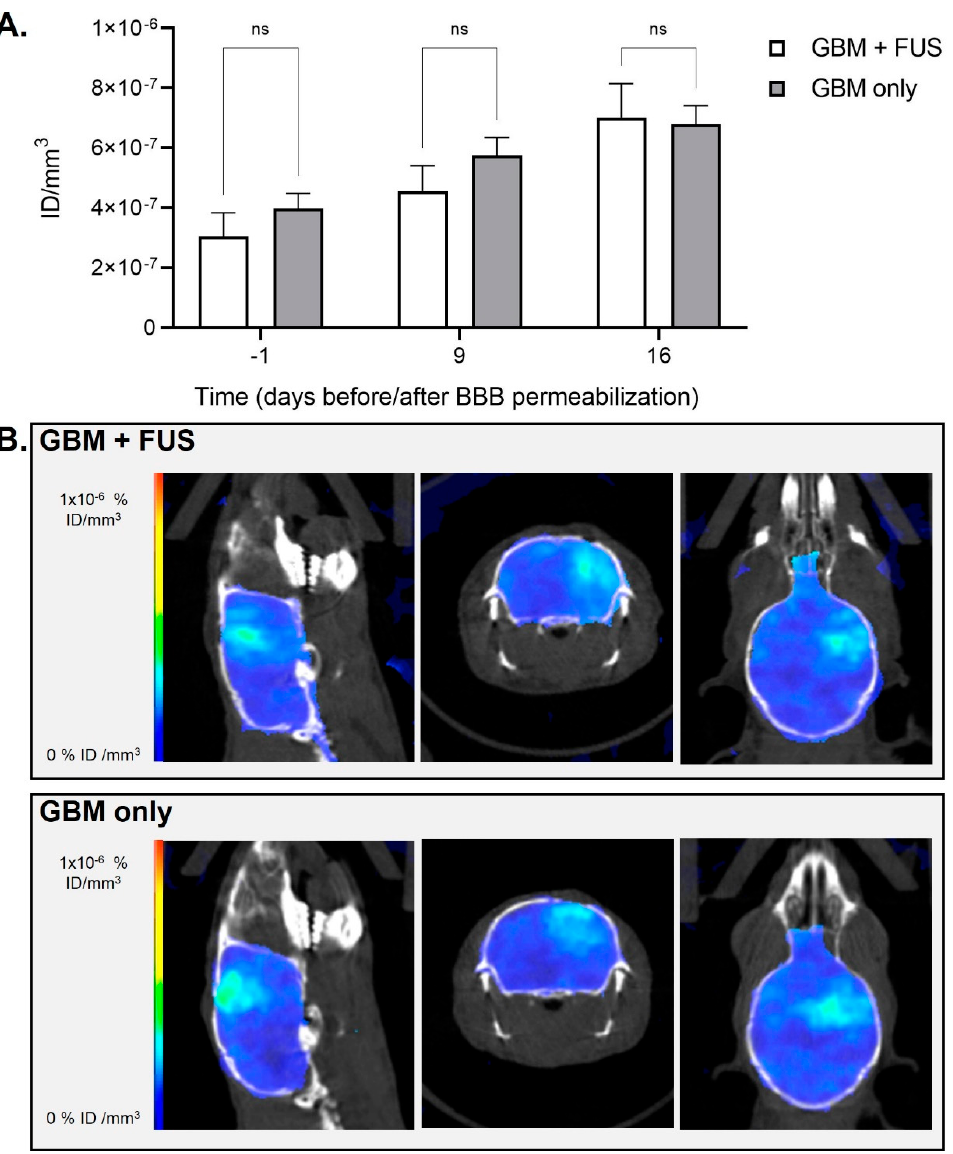
Figure 5. Tumor growth and [68Ga]Ga-RGD 2 PET/CT imaging following BBB permeabilization by focused ultrasound on tumor-bearing animals. ( A ) Quantification of [68Ga]Ga-RGD 2 activity in animals of group “GBM + FUS” (tumor-bearing animals undergoing FUS-mediated BBB permeabiliza- tion) and group “GBM only” (tumor-bearing animals without FUS-mediated BBB permeabilization) before and after BBB permeabilization. Results are expressed as injected dose per tissue volume (ID/mm 3 ; n = 5 per group; mean ± SEM; ns: not significant); ( B ) Brain representative images ob- tained by [68Ga]Ga-RGD 2 -mediated PET/CT imaging at day 16 after hemispheric trajectory focused ultrasound in an animal of group “GBM + FUS” (tumor-bearing animals undergoing FUS-mediated BBB permeabilization) and an animal of group “GBM only” (tumor-bearing animals without FUS- mediated BBB